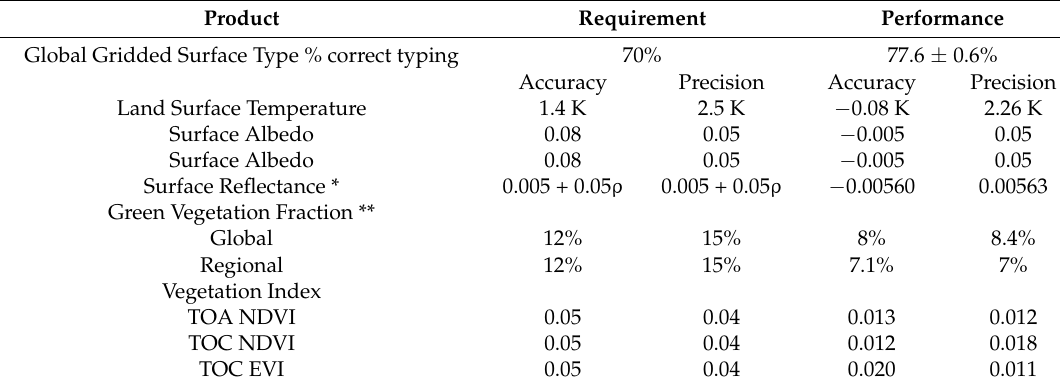
Table 5. S-NPP VIIRS land products